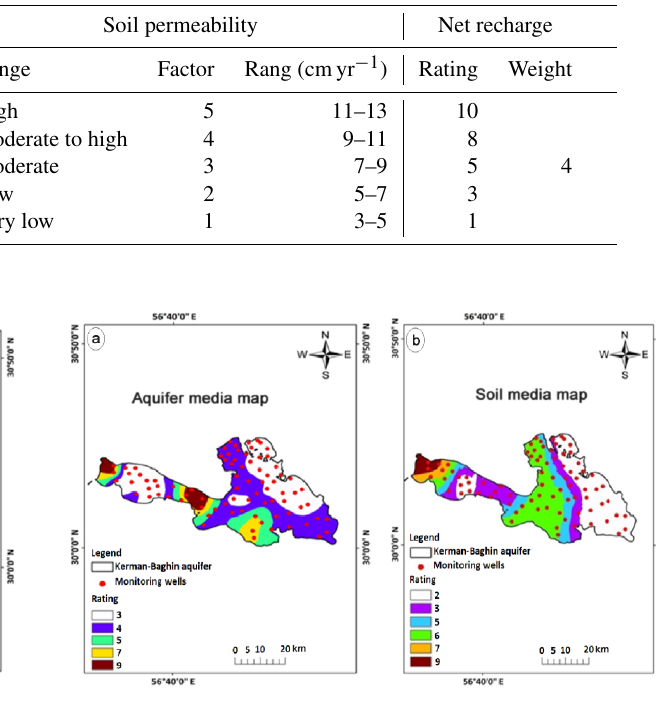
Figure 2. The Kerman–Baghin aquifer rated maps of (a) water table depth and (b) net recharge.